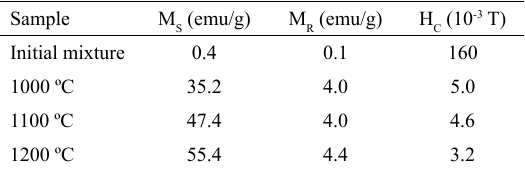
), remanent magnetization S